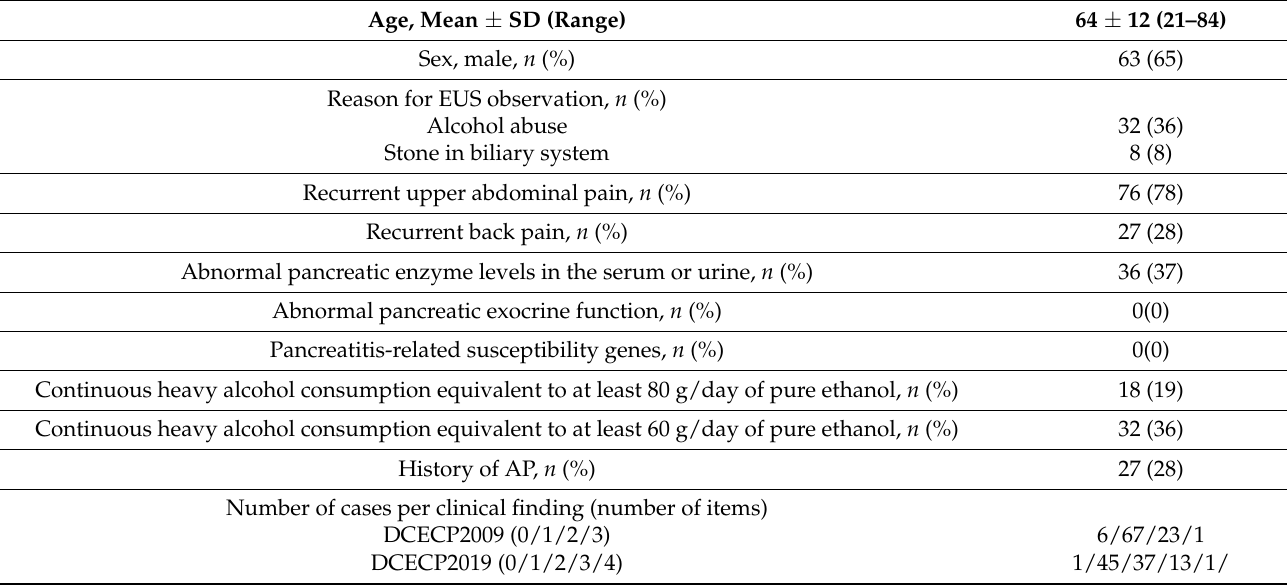
Table 1. Patient characteristics and clinical features in DCECP2009 and